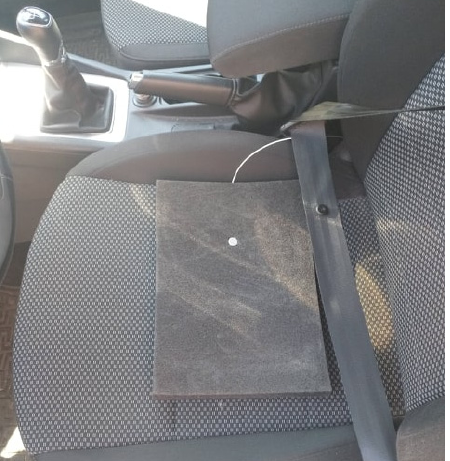
Figure 3. Acceleration sensor placed on the seat of the vehicle under the driver’s buttock.